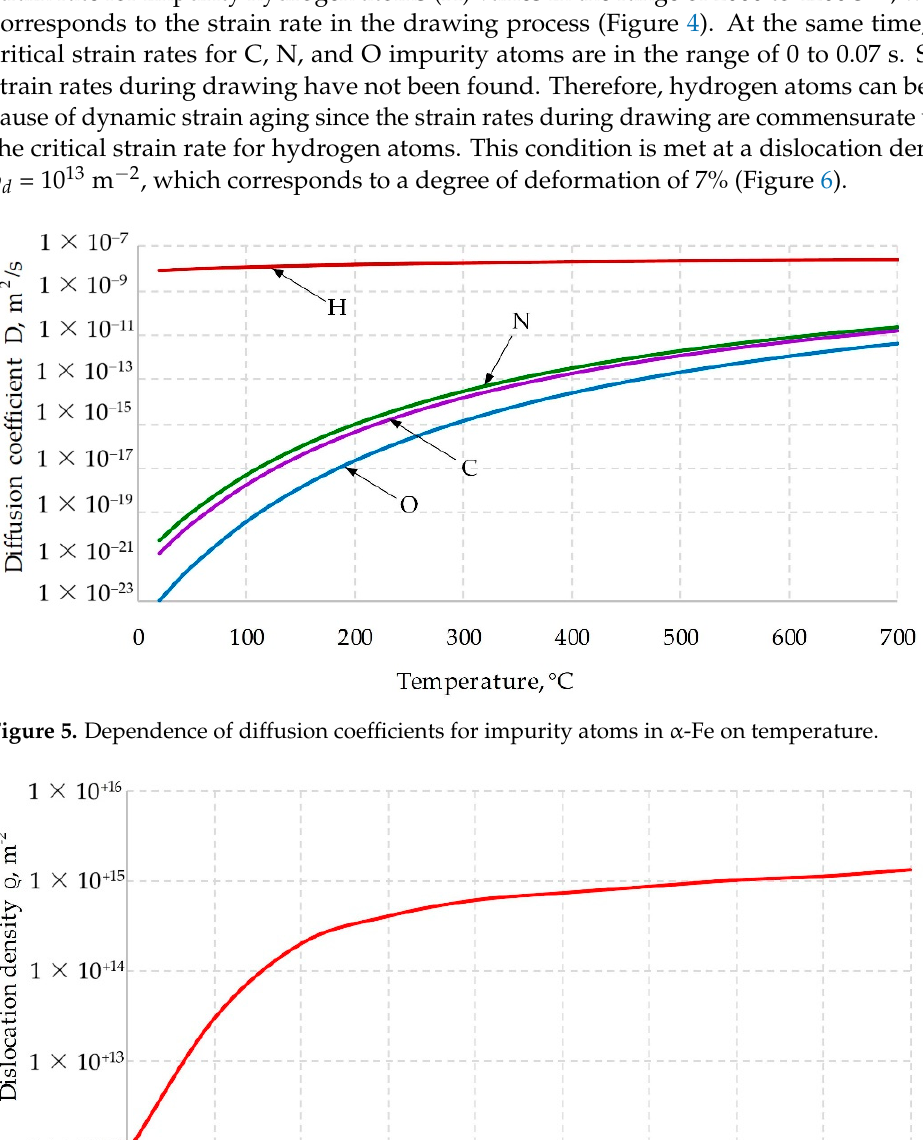
Table 3. Parameters for determining impurity diffusion in α -Fe.